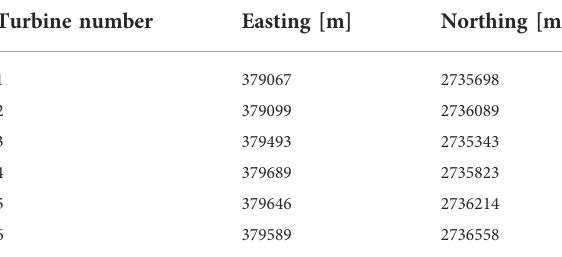
TABLE 1 Wind farm micrositting layout for 13.8 MW